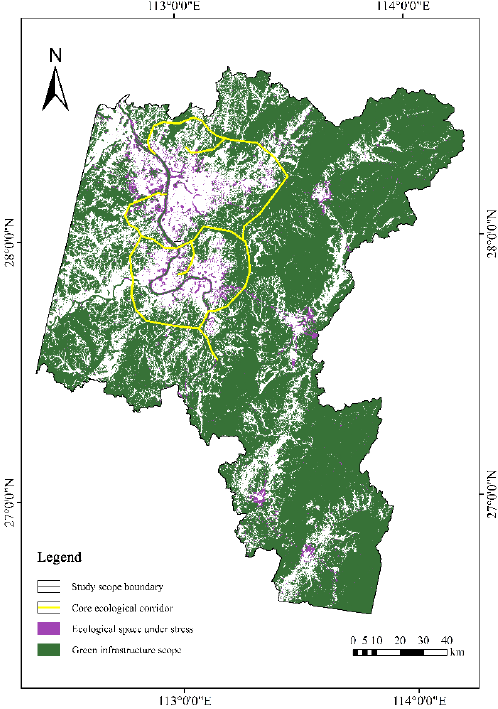
Figure 6. Stressed green infrastructure in the “ecological protection planning control” scenario in 2030. Table 5. Characteristics of stressed green infrastructure in different scenarios.